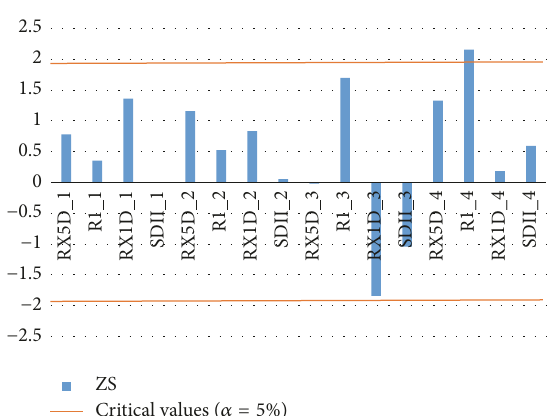
Figure 6: Observed values of Mann-Kendall’s test statistic ZS.